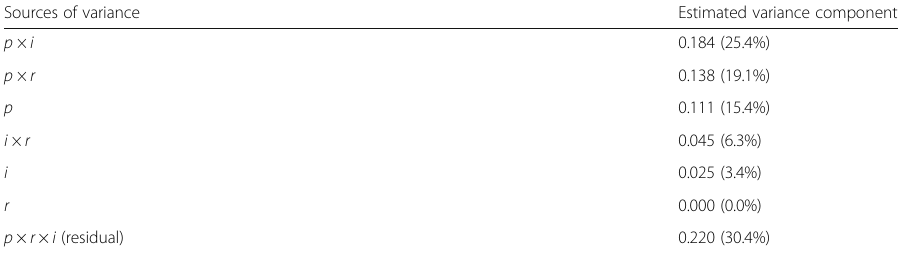
Table 4 Estimated variance components Sources of